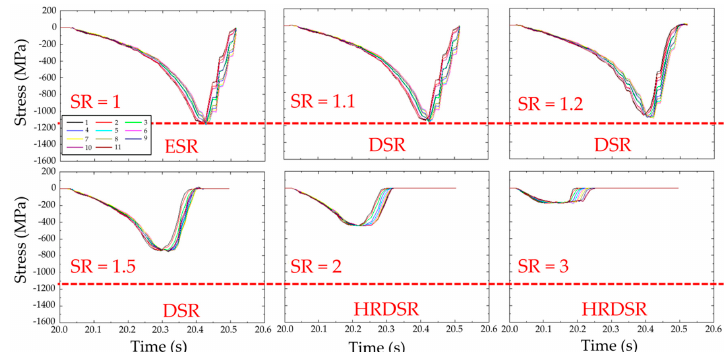
Figure 10. The e ff ect of SR on the roll stress during passage of the sheet material through the rolls. The analyzed points in the enmeshed domain of simulation (Figure 8) and the roll stress along the thickness of the sheet using finite element simulation for rolling with different SRs for a thickness reduction of 70% by a single pass under a high friction condition (the friction factor at the roll/sheet interface = 0.95) [47].